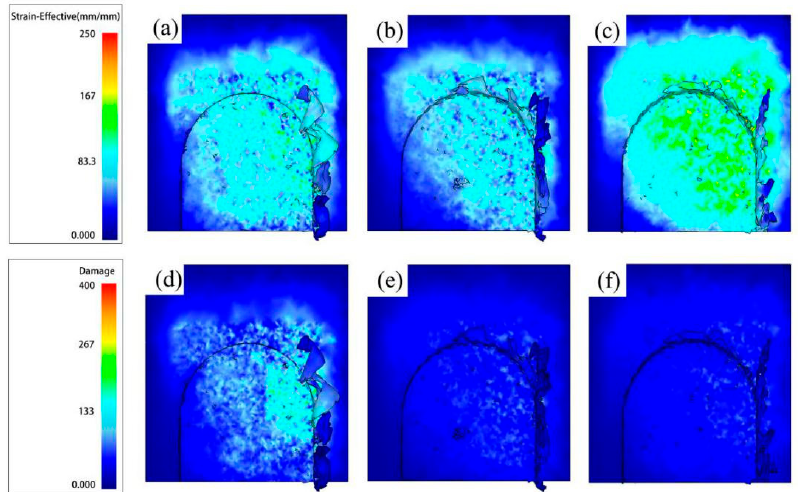
Figure 8. Equivalent plastic strain cloud image and damage cloud image with different A. ( a , d ): A